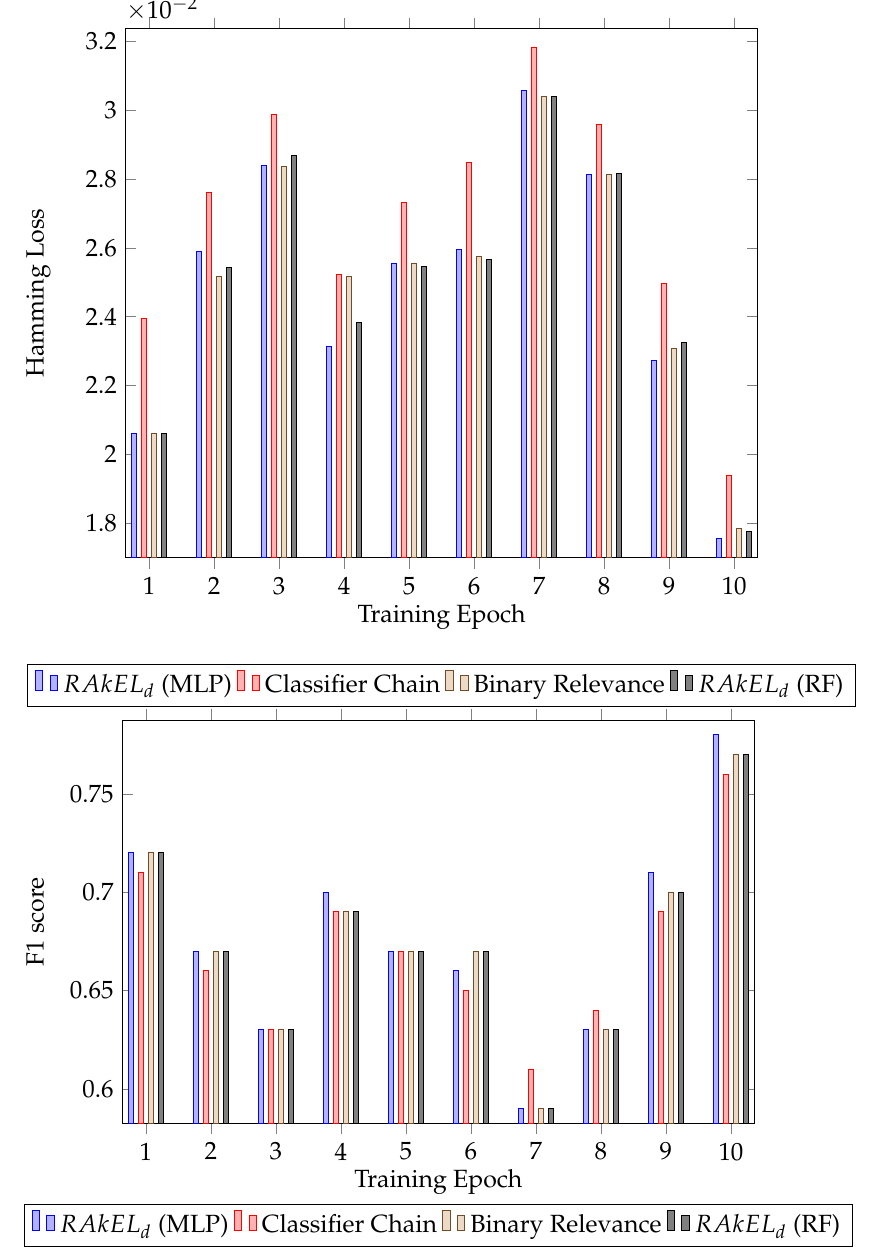
Figure 3. Classification results for House A. Hamming loss for each classifier per validation epoch and F1 score for each classifier per validation